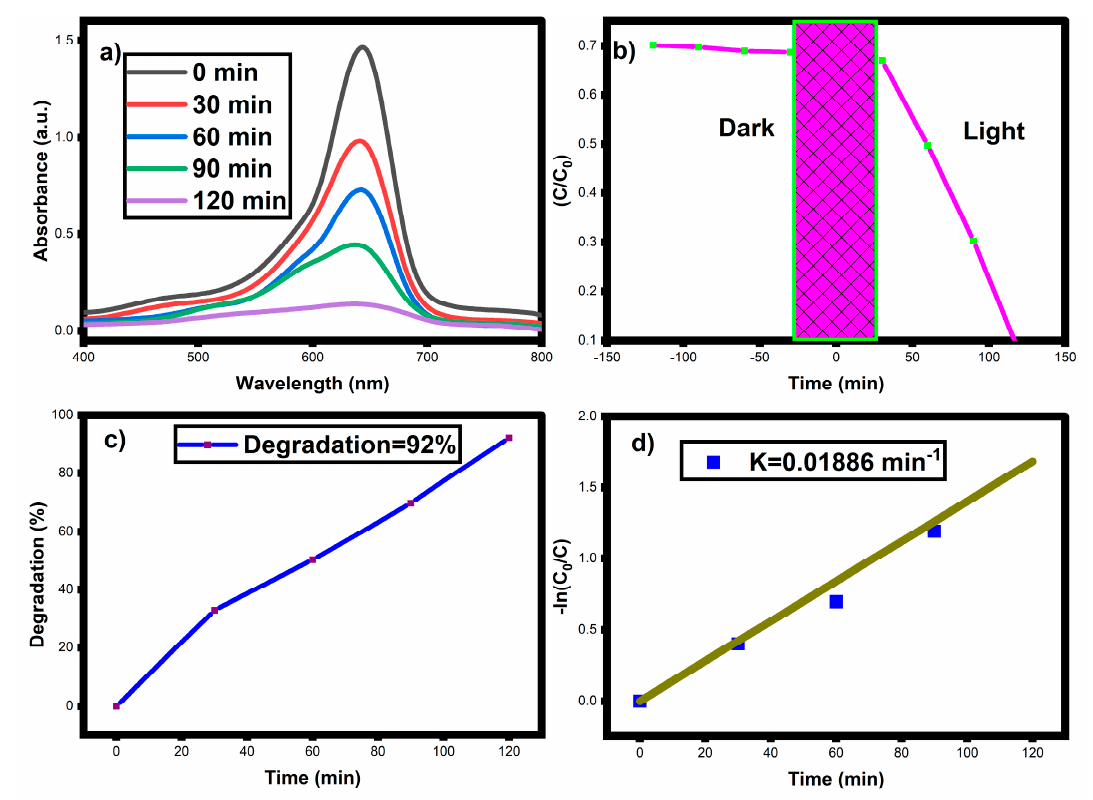
Figure 7. ( a ) MB dye degradation spectra, ( b ) Plots of dark and light condition (C/C 0 ), ( c ) Degradation efficiency (%) spectra and ( d ) Plots of ln(C 0 /C) versus reaction time over MB dye molecules using green synthesized NiSe NPs.